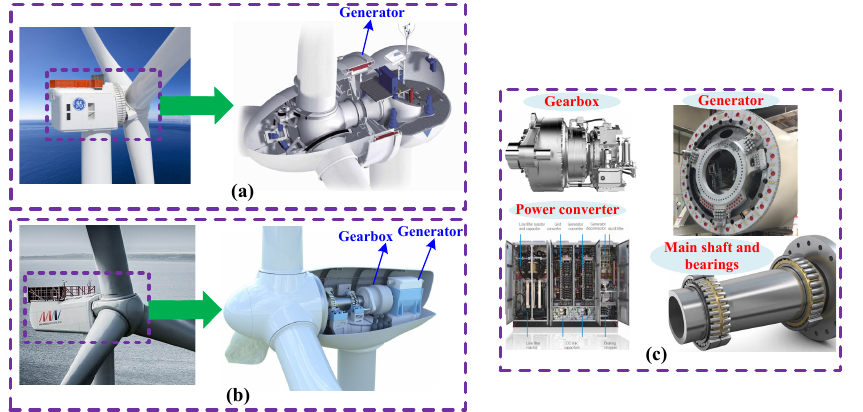
Figure 1. Drivetrain configurations and main components. ( a ) Direct-drive drivetrain, ( b ) Geared drivetrain, ( c ) Drivetrain breakdown (photos and figures are adopted from